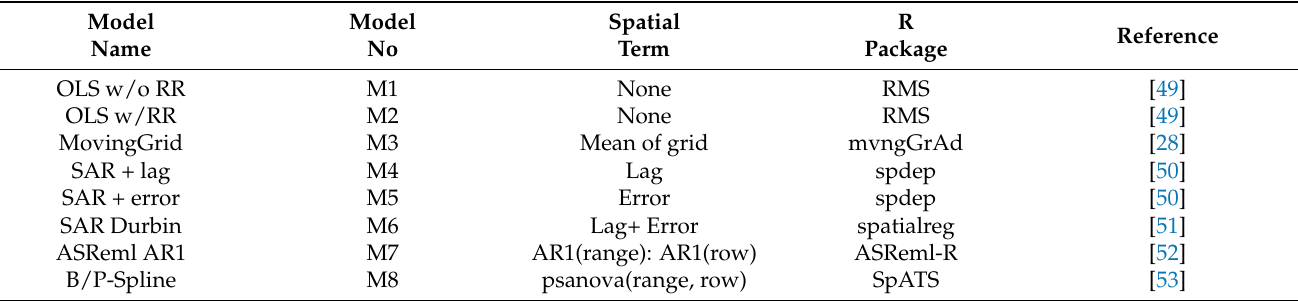
Table 3. Summary of the eight models compared in the research. See model descriptions (OLS, SAR etc.) in manuscript, Section